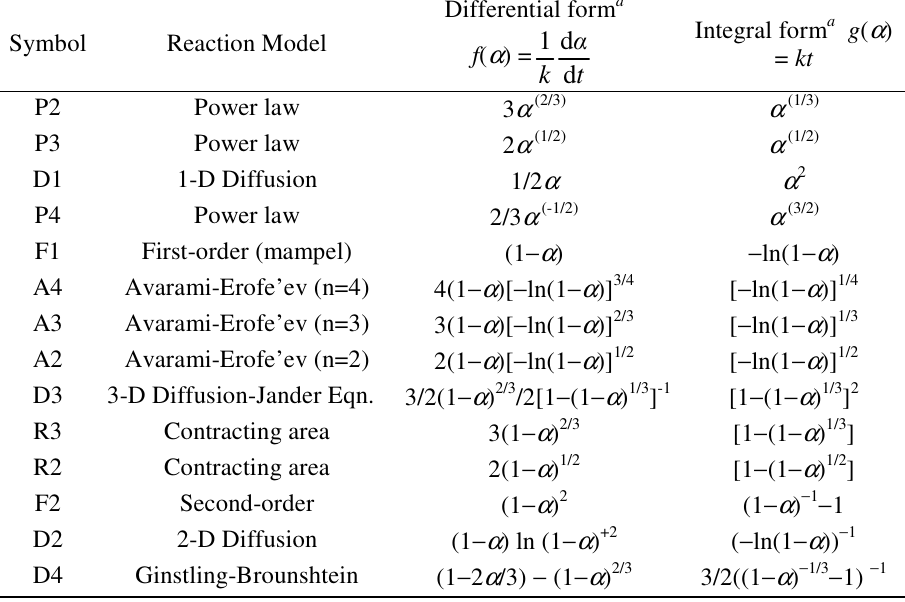
Table 1. Algebraic expressions of f ( α ) and g ( α ) for the reaction models considered in the present work